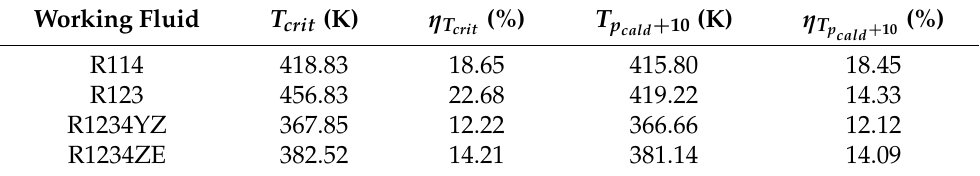
Table 4. Comparison of performance ( η ) depending on the inlet turbine